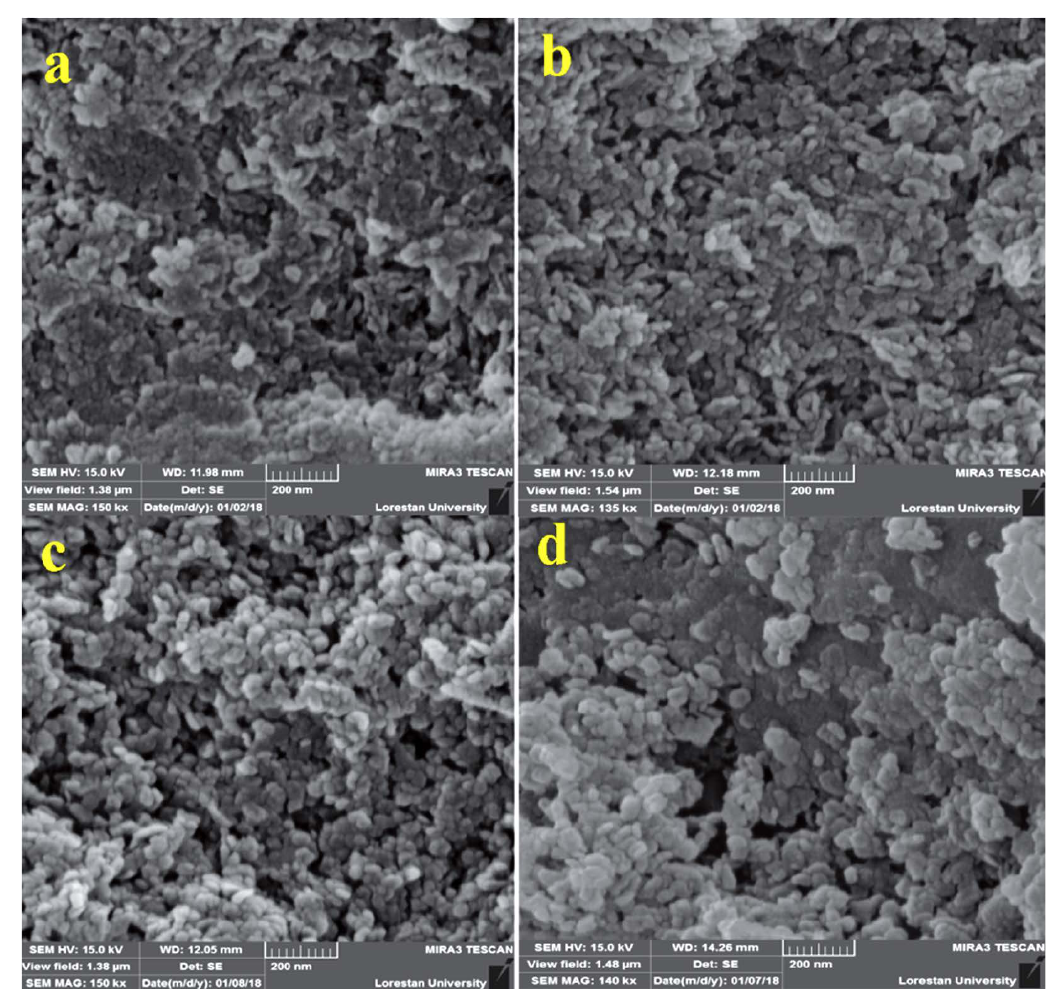
Figure 3. SEM images of (a) Mg-Al-LDH and Mg-Al-LDH modified with NaOH solutions at pHs of (b) 10, (c) 13 and (d)